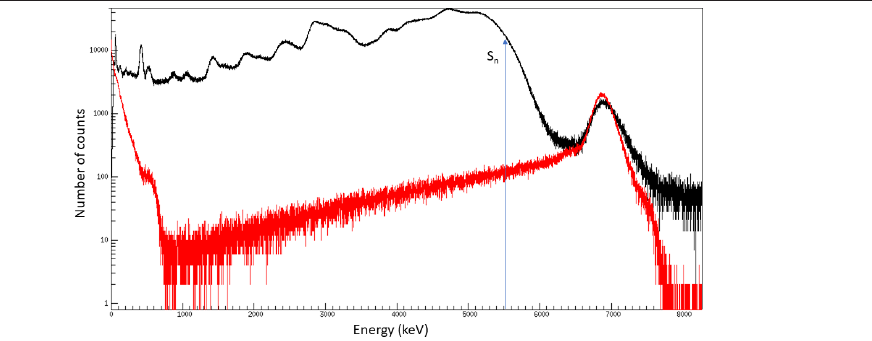
Figure 3. Simulation of the MTAS response function to the neutrons emitted after β decay of 87 Br (red) in comparison with experimental MTAS spectrum of full 87 Br β decay (black). Spectra are normalized to the number of counts between 6500 and 7600 keV.